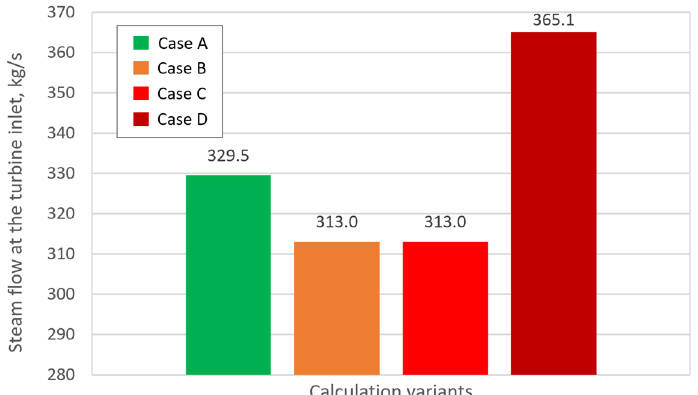
Figure 13. Mass flow rate of steam at the inlet to the turbine for different parameters of steam feed- ing the turbine.